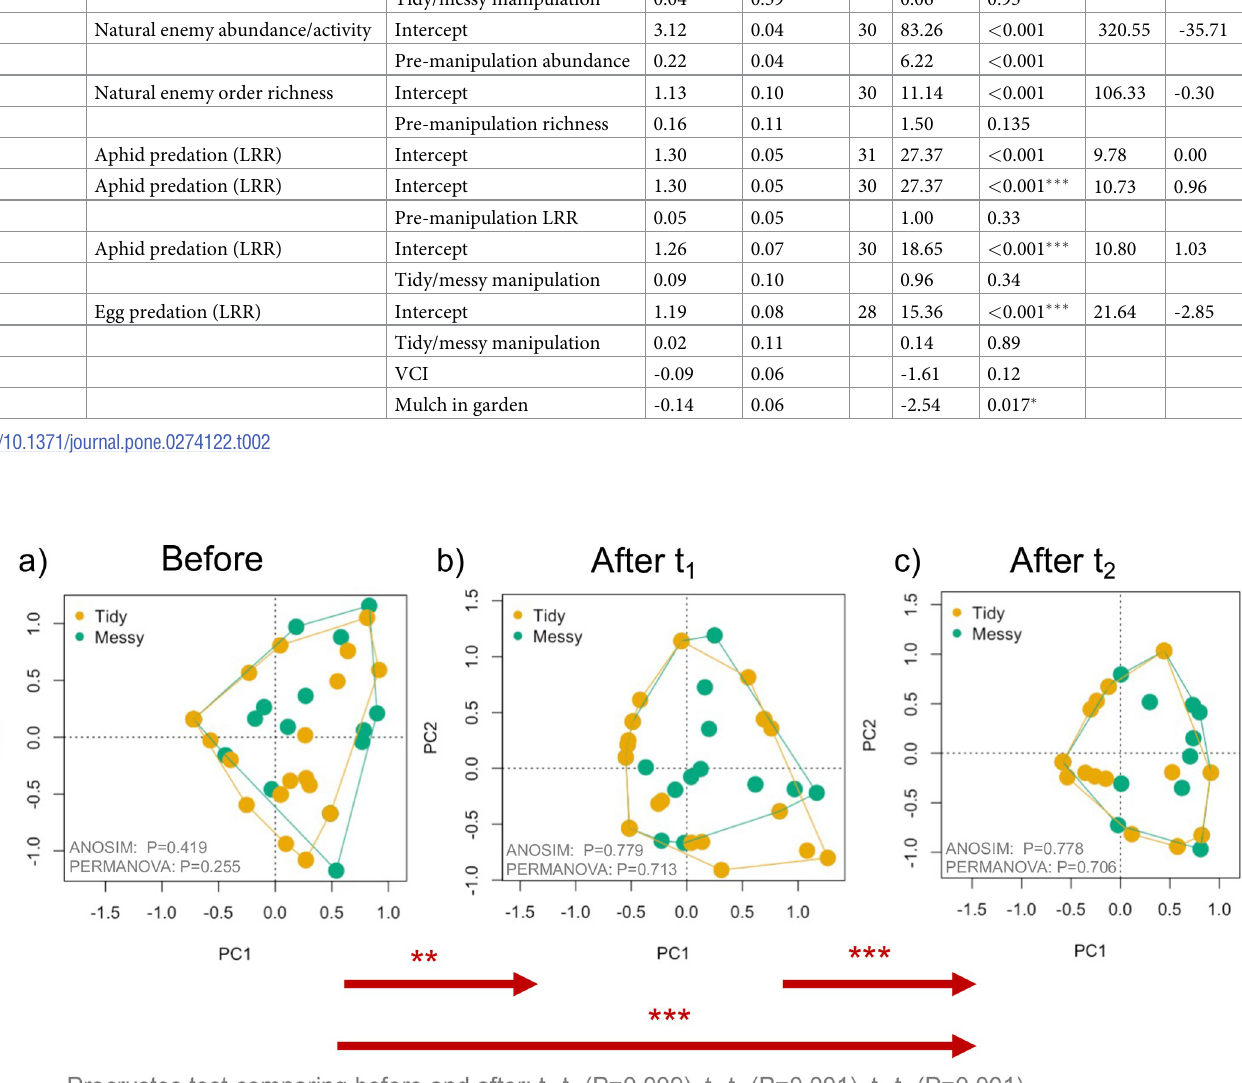
PLOS ONE | https://doi.org/10.1371/journal.pone.0274122 September 22,